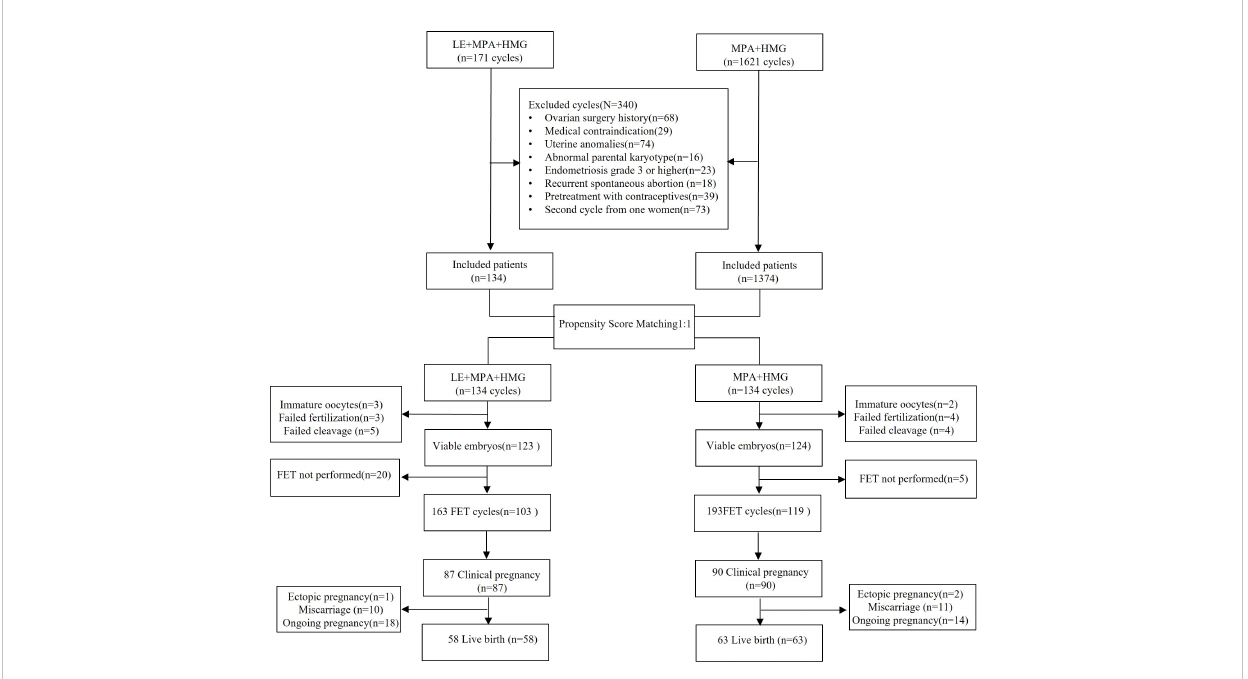
FIGURE 1 Flow chart of the study. IVF, In vitro fertilization; ICSI, Intracytoplasmic sperm injection; FET, Frozen embryo transfer; LE, Letrozole; MPA, Medroxyprogesterone acetate; hMG, Human menopausal